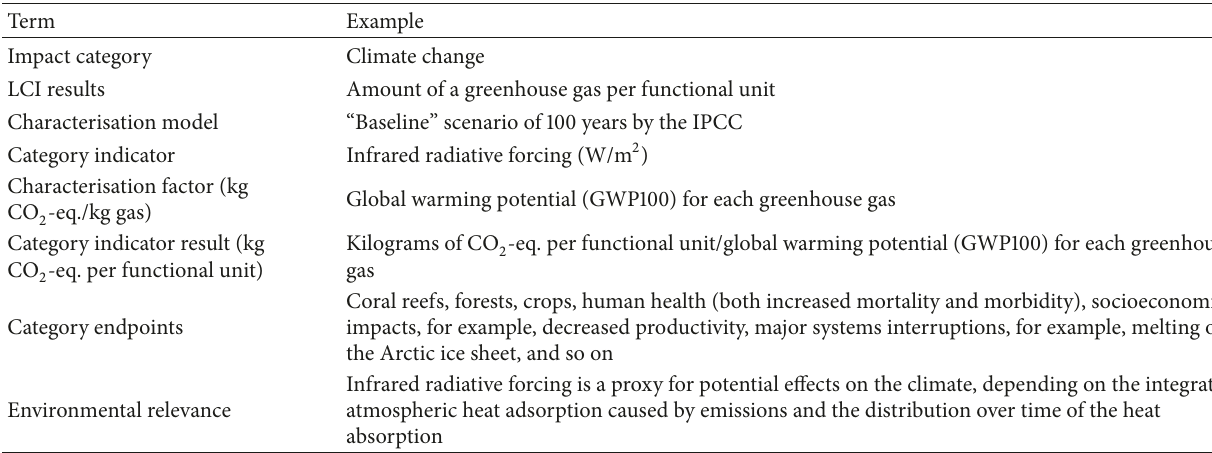
Table 3: Examples of terms in an impact assessment (LCIA) DIN EN ISO